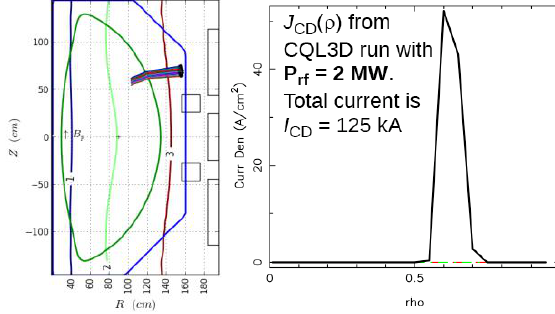
Fig. 16 : off axis efficiency from a 70 cm high launcher. The efficiency is 0.063 A/W and the corresponding  is